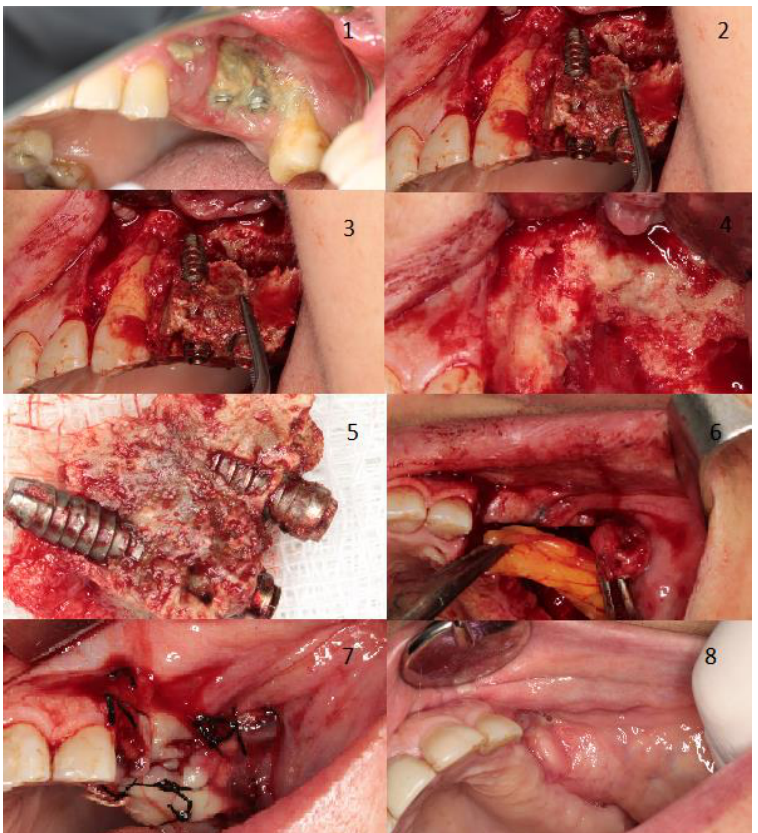
Figure 3. Woman aged 81 years with osteoporosis treat with alendronate. The patient developed stage 3 MRONJ with large areas of bone exposure and pus exudation on the left maxilla plus a chronic oroantral fistula on the left maxillary sinus. The patient experienced severe pain and had severe signs of infection. The trigger factor was dental implants placement (Image 1). Initially, we performed an incision and flap elevation to visualize the affected area (Image 2). Then, two extractions were performed due to the poor dental prognosis, implant extraction, and resection of necrotic bone was also performed (Images 3–5). To close the oroantral fistula, an intraoral bichectomy was performed to harvest tissue. Obtained tissue was placed in the resection area and primary wound closure was achieved (Images 6 and 7). Two months after treatment, total resolution was achieved (Image 8).